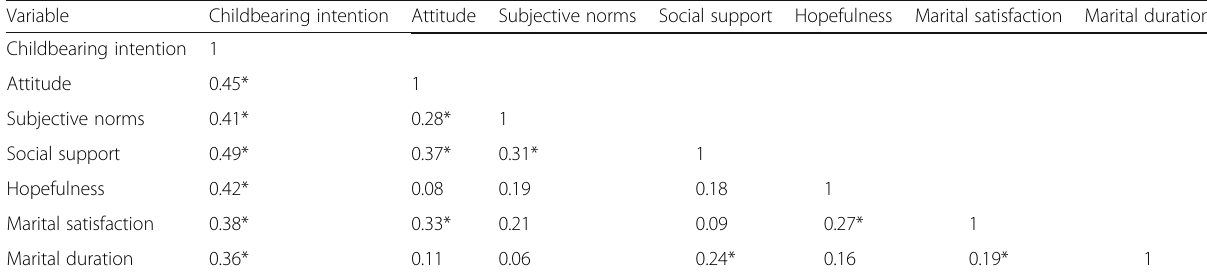
Table 4 Correlations between the childbearing intention and psychological factors Variable